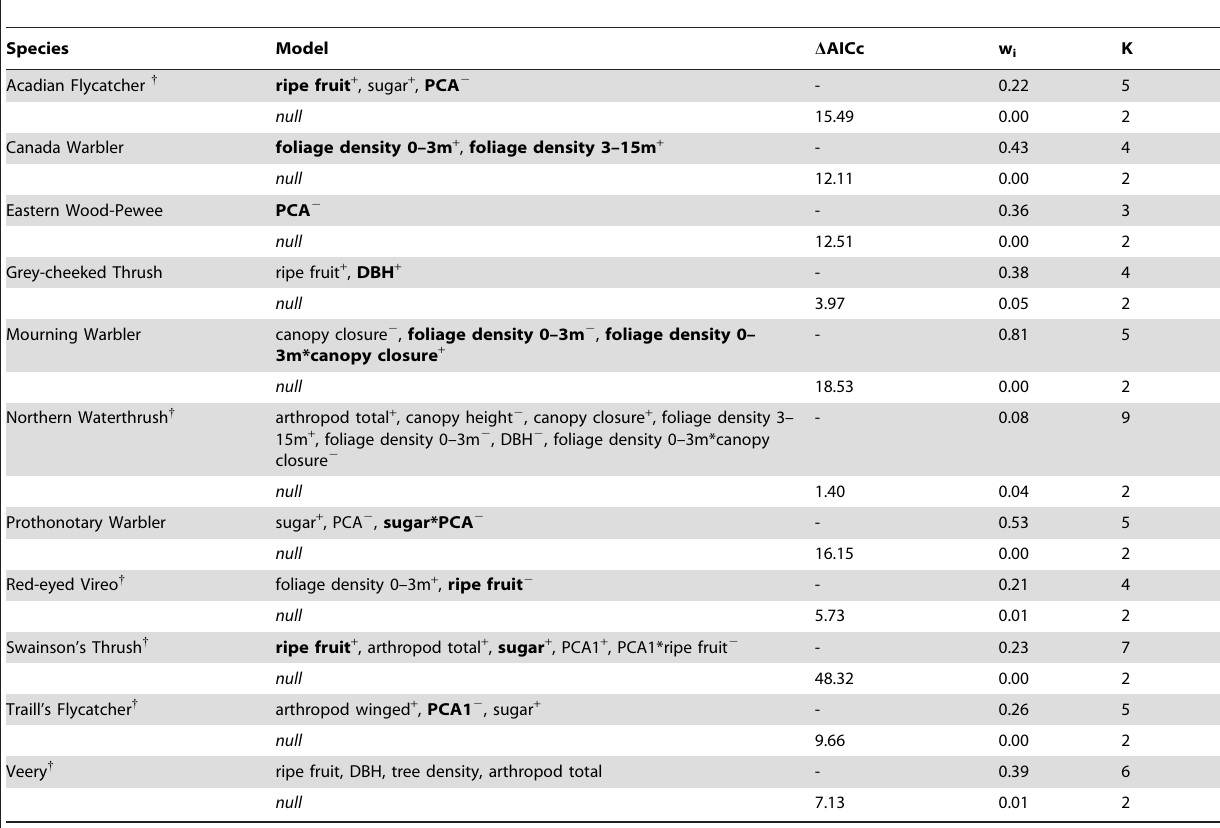
Table 4. Top or averaged linear models (within 2 AICc values of the top model) and associated null models for comparative purposes for 11 migrant species captured in Tortuguero, Costa